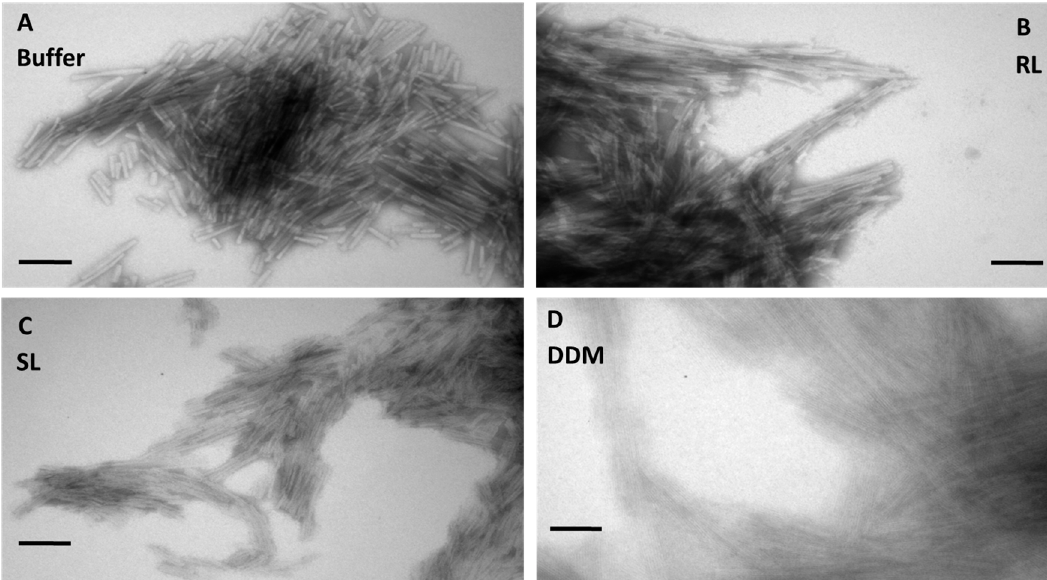
Figure 3. The 3474 aggregates formed in buffer ( A ), RL ( B ) and SL ( C ) are morphologically indistinguishable. Electron microscopy shows the aggregates formed in DDM ( D ) are morphologically different compared to those formed in pure buffer and RL/SL. The scale bar indicates 100 nm.